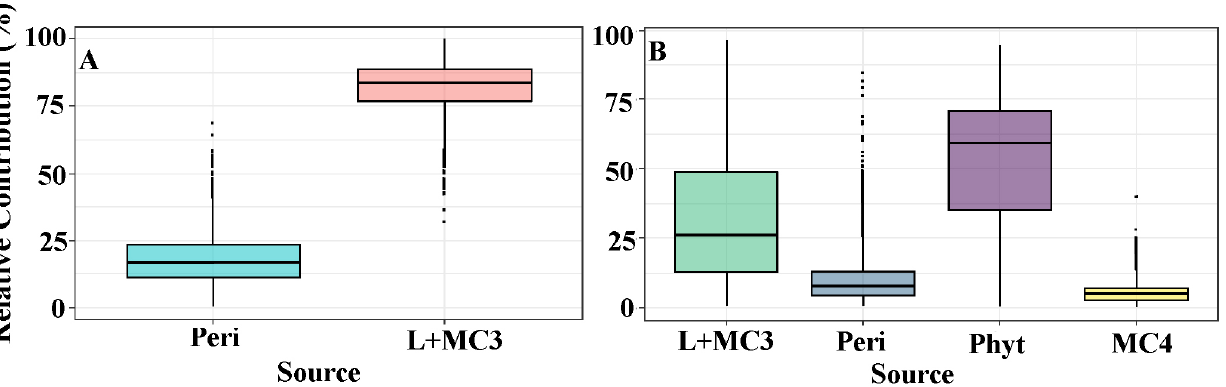
FIGURE 3 | Relative contributions (%) of autotrophic energy sources in the detritus collected from two Amazonian rivers, in Amazonas, Brazil . A. Negro River; B. Solimões River. L+MC3 = Group of leaves + Macrophyte; Peri = Periphyton; Phyt = Phytoplankton; MC4 = C